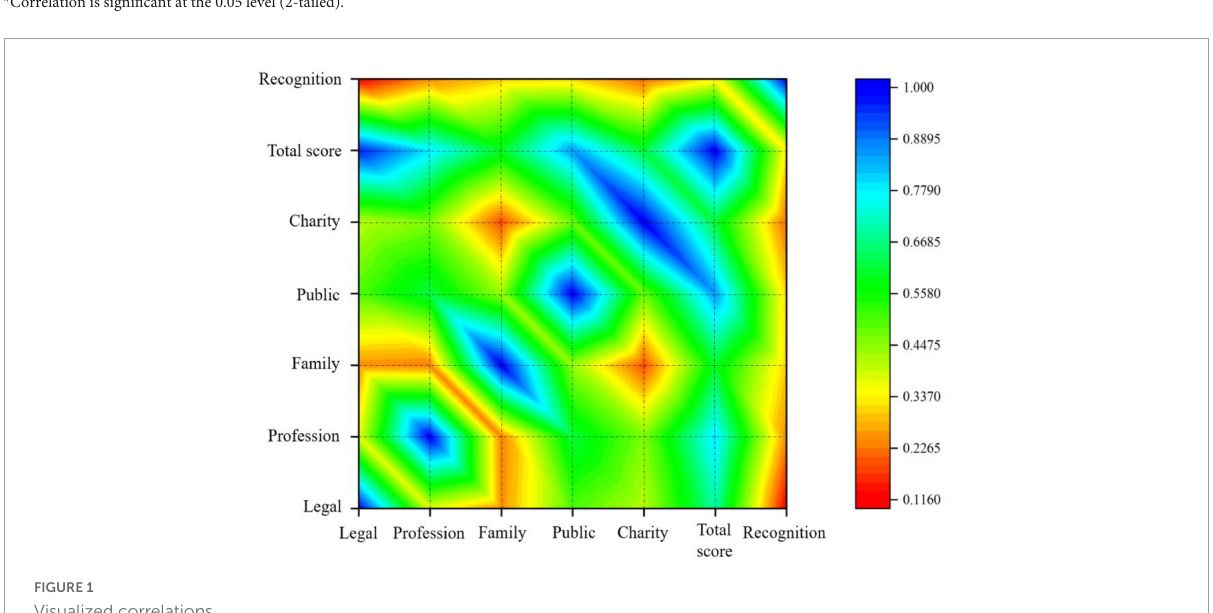
FIGURE1 Visualized correlations.